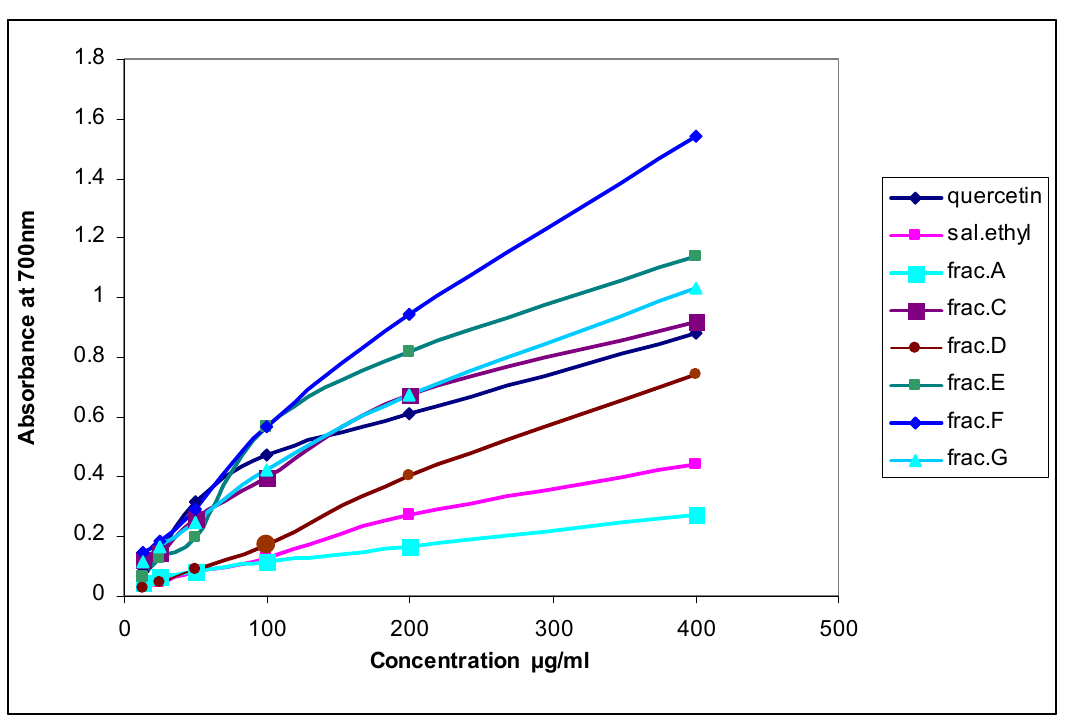
Figure 1: Reducing power of Salvia mirzayanii ethyl acetate subfractions compared with quercetin (was diluted 1:10) as standard. Subfraction C (was diluted 1:2) and subfraction D (was diluted